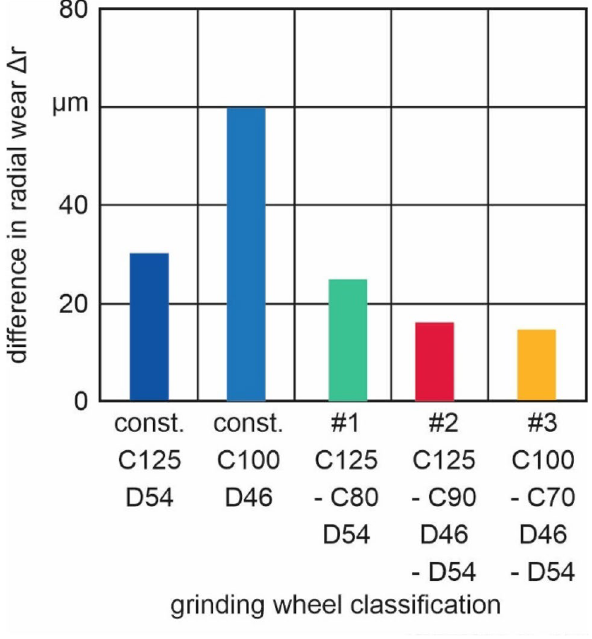
Fig. 8 Absolute radial wear differences for the investigated grind- ing